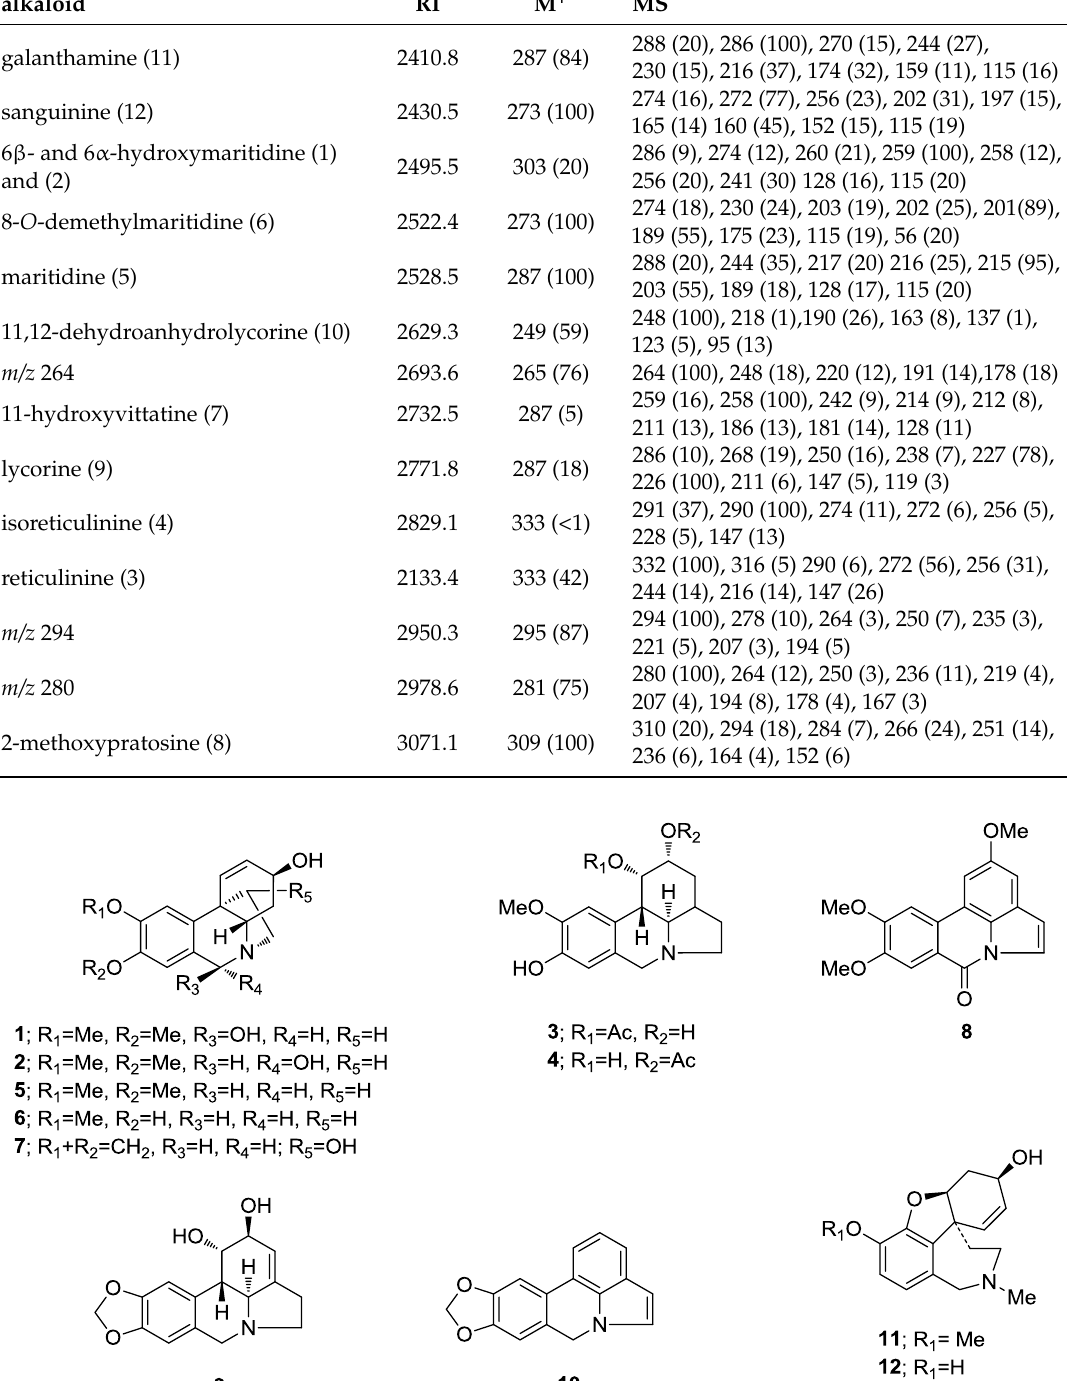
Table 1. Alkaloids identified in H. reticulatum by GC-MS.